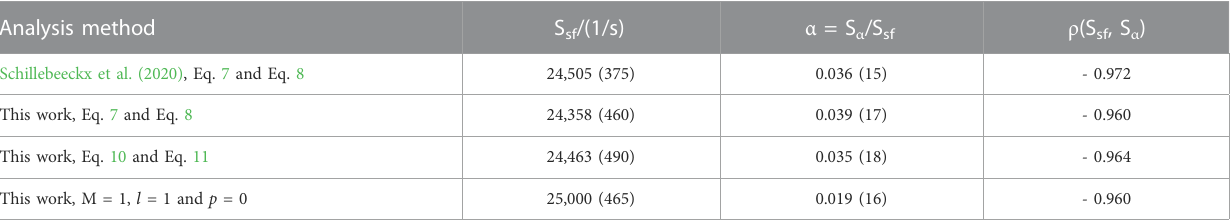
TABLE 14 Neutron production rate due to spontaneous fi ssion S sf and α -ratio resulting from different methods to analyse the experimental data in Table 12. The results are for a cooling time of 6,437 days. Analysis method